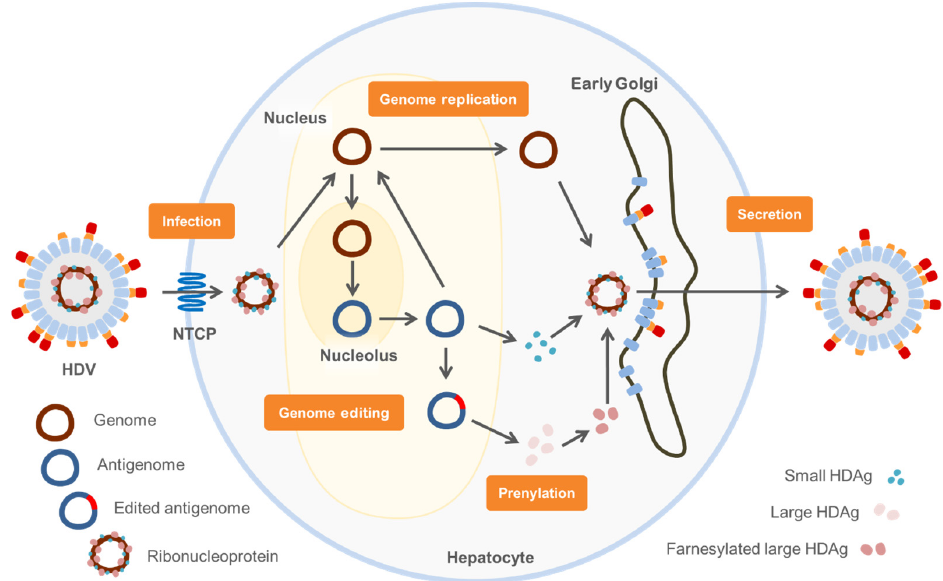
Figure 3. Hepatitis D virus life cycle. The hepatitis D virus enters hepatocytes via the NTCP. HBsAg